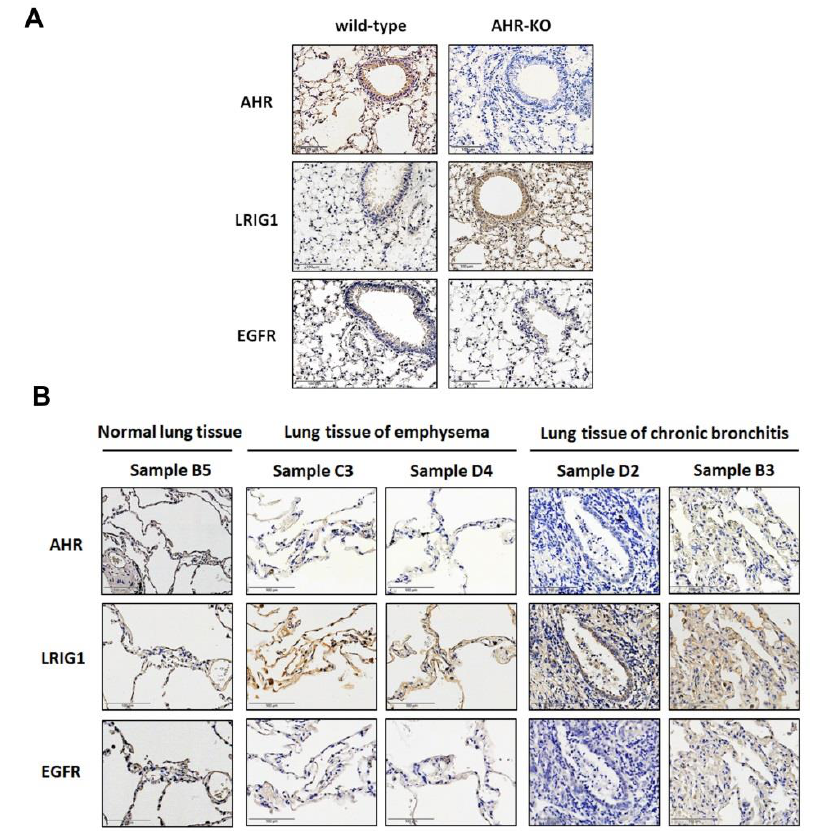
Figure 6. The expression of AHR, LRIG1, and EGFR in lung tissues, involving mice and humans. ( A ) AHR was undetectable in samples obtained from AHR-KO (C57BL/6−Ahr tm1.2Arte ) mice. Repre- sentative images showed the inverse expression between AHR (or EGFR) and LRIG1 ( n = 5). ( B ) The expression level of AHR, LRIG1, and EGFR in normal, emphysema, and chronic bronchitis lung tissues were detected. We found an apparent LRIG1 reactivity, coincided with poor AHR (or EGFR) reactivity in emphysema ( n = 2) and chronic inflammatory lung tissues ( n = 5). The upregulation of LRIG1 expression correlated negatively with AHR (or EGFR). The donor’s gender, age, and pathology diagnosis are summarized in Table S2. The high-magnification images are shown in Figure